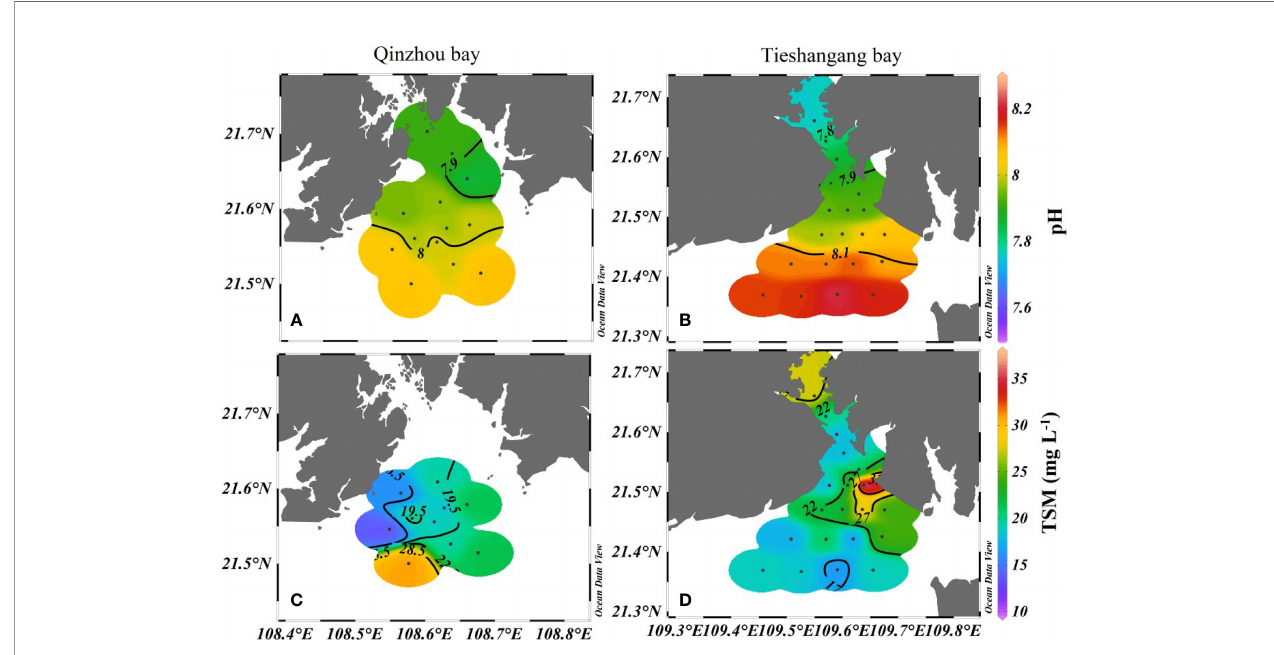
FIGURE 3 | Spatial distributions of pH (A, B) and TSM (C, D) in Qinzhuo Bay and Tieshangang Bay during the sampling